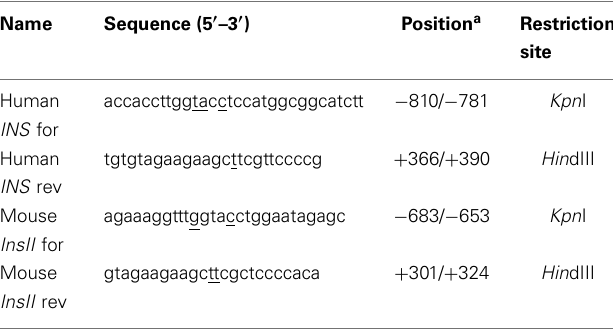
Table 1 | Primers used for plasmid construction of human and mouse INS promoter-containing vectors